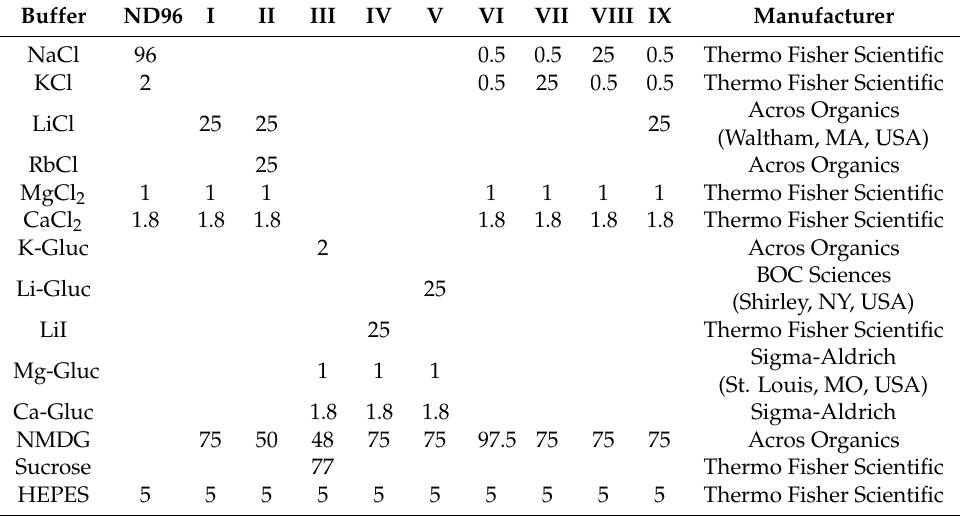
Table 1. Chemical composition of buffers used in Xenopus oocyte ion uptake and electrophysiology experiments. All values in the table are in mM. Osmolality of the buffers was confirmed to be 195 ± 5 mOsmol/kg H 2 O using a vapor pressure osmometer (Wescor, Logan, UT, USA). The pH of all buffers was adjusted to 7.5 with NaOH, NMDG, HCl, or gluconic acid depending on the dominant cation and presence/absence of Cl − in the buffer. Ouabain (0.5 mM) was added to all buffers except ND96.